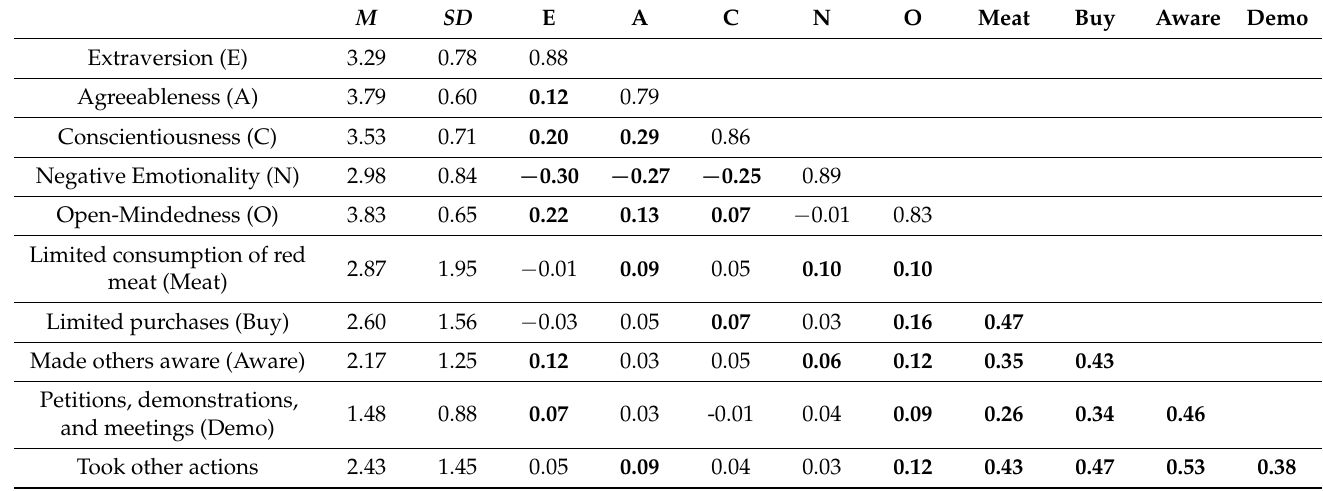
Table 1. Descriptive statistics and zero-order correlations between